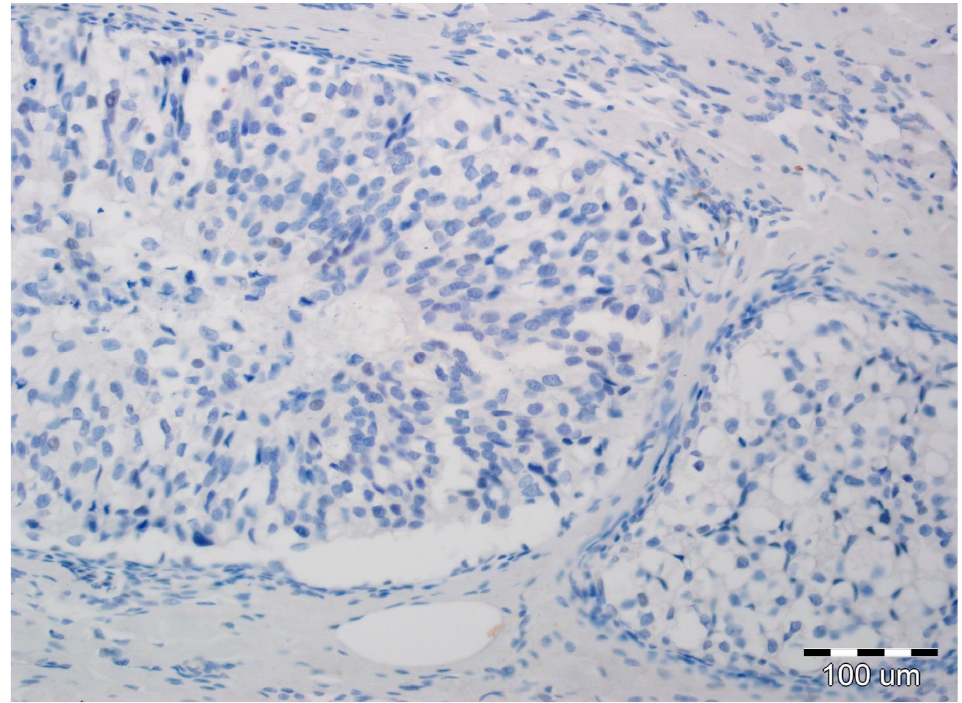
Figure 1. Ductal carcinoma in situ with lack of N-cadherin expression in luminal epithelial cells and the stromal compartment (hematoxylin, ×200).